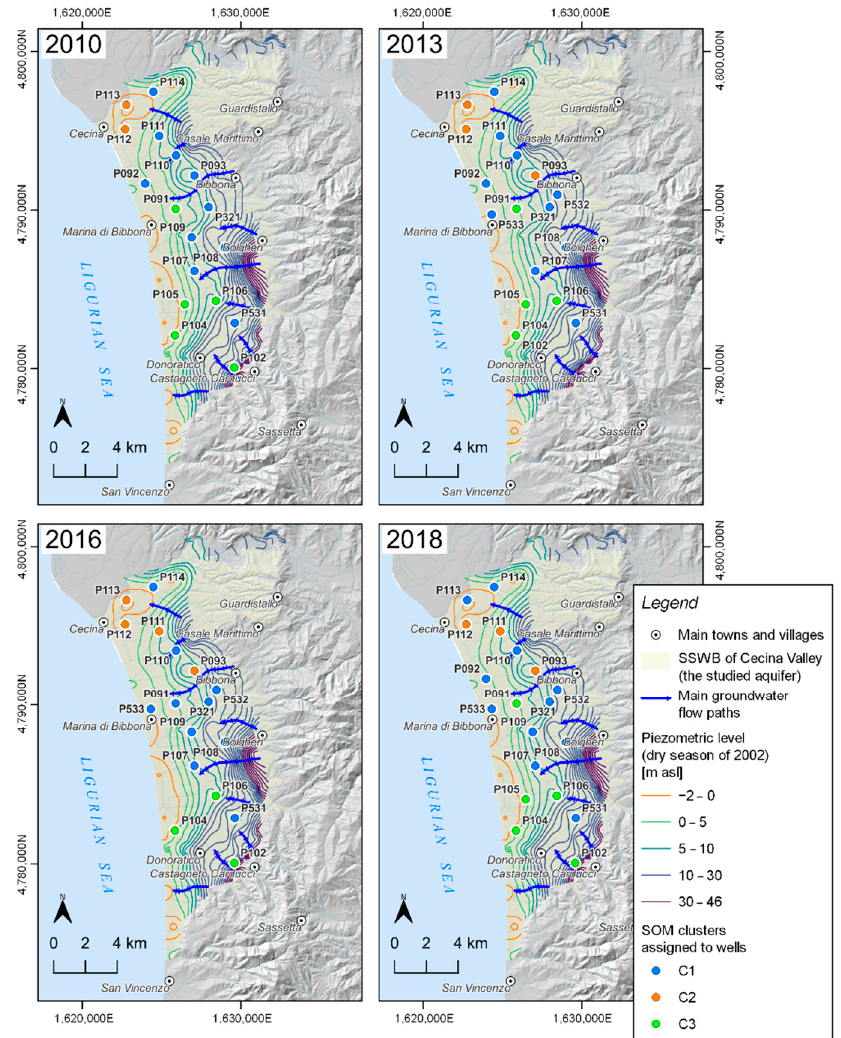
Figure 10. Location of the sampling wells superimposed to the hydraulic head recorded in 2002 according to [14].